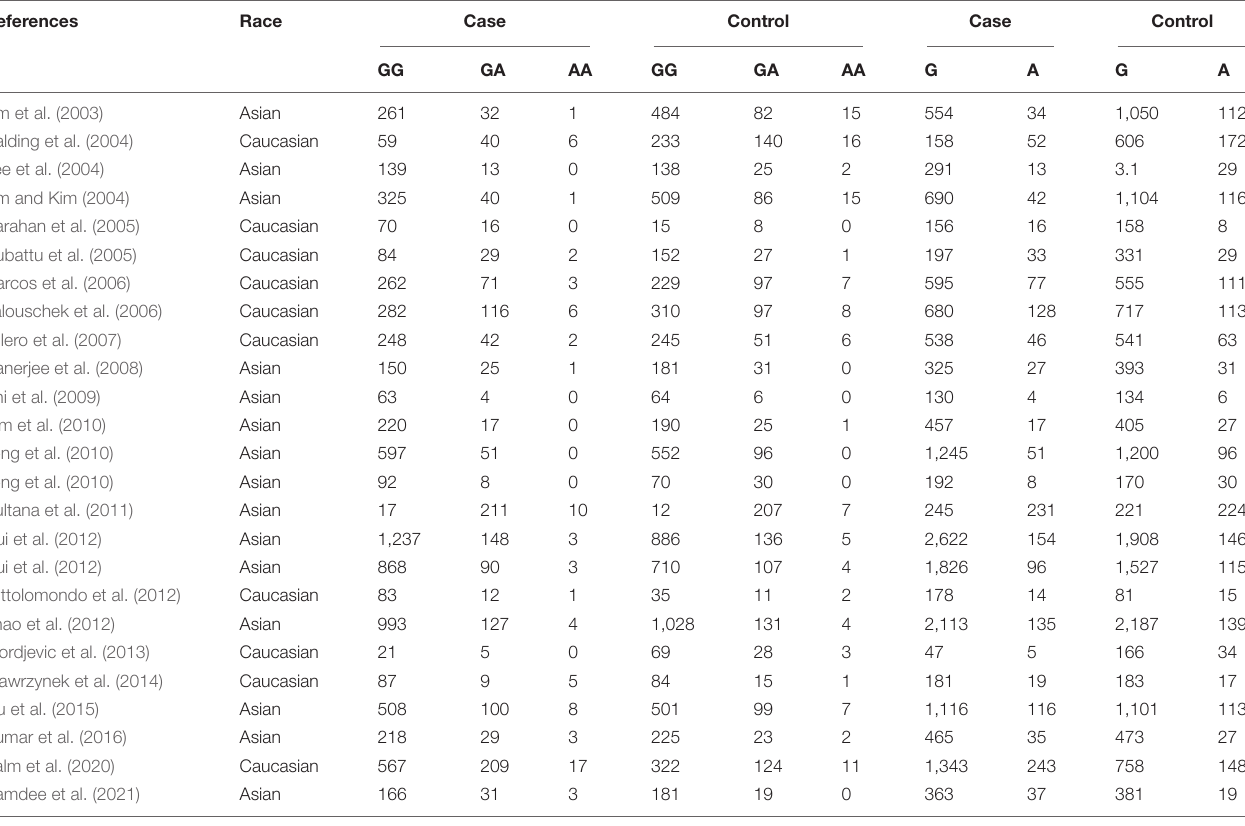
TABLE 1 | Summary of studies exploring the relationship between rs1800629 of TNF- α gene polymorphism and IS.